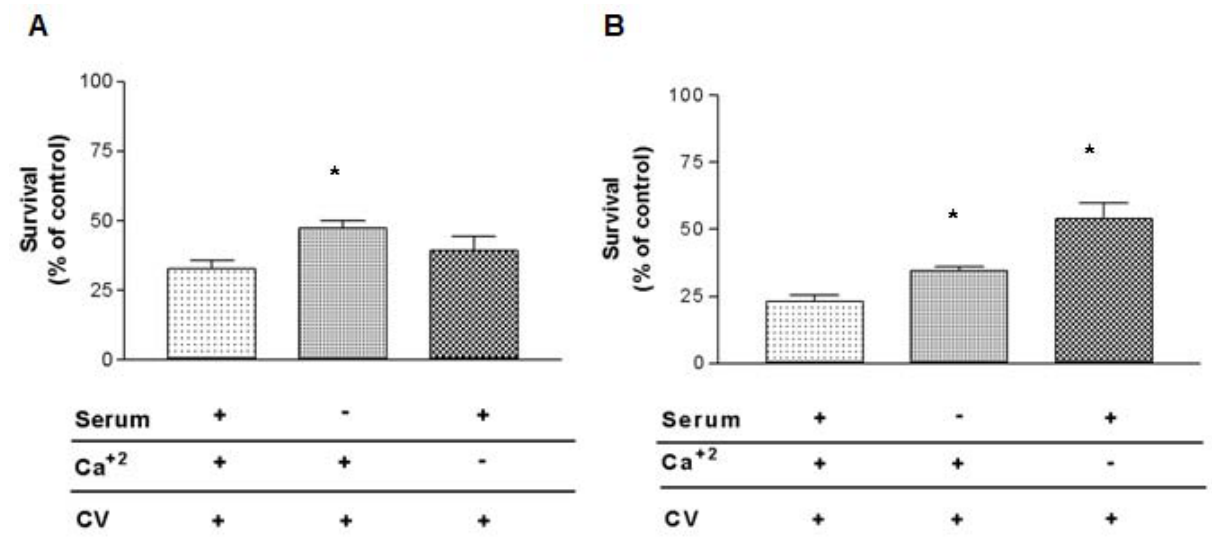
Figure 5. Calcium and growth factors influence on CV antitumoral effect: ( A ) GH3 cells and ( B ) RT2 cells. Brain tumor cells were treated with 10 μg/mL of CV for 48 hours in the presence and absence of calcium and FBS. In GH3 cells, the CV antitumoral effect was reduced only in the absence of serum. In RT2 cells, the CV antitumoral activity was reduced as in the absence of either serum or calcium (*p <